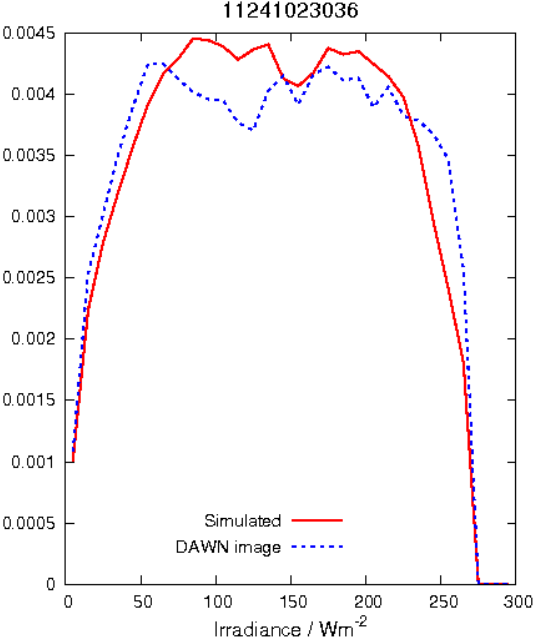
Figure 21. Exemplary radiance probability density function of image ID 11241023036. The DAWN image was acquired on 31 August. The RPDF shows an average radiance of approx. 151 W/sr/m 2 and minimal and maximal values of 0. (black pixel or deep shadow) and 260 W/sr/m 2 , respectively. The radiance bins are 10 W/sr/m 2